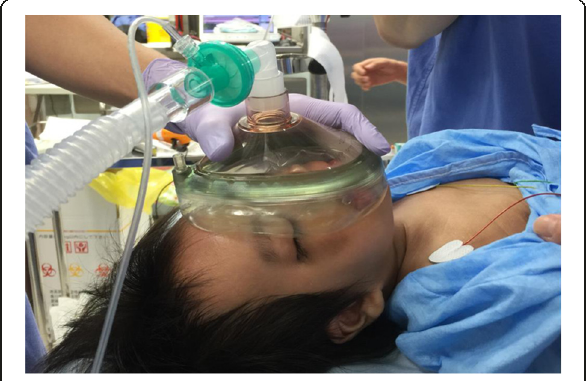
Fig. 2 Photography of manual ventilation of the patient. A mask for large adults (The Original King Mask ™ , size 6) was suitable to cover both corners of the